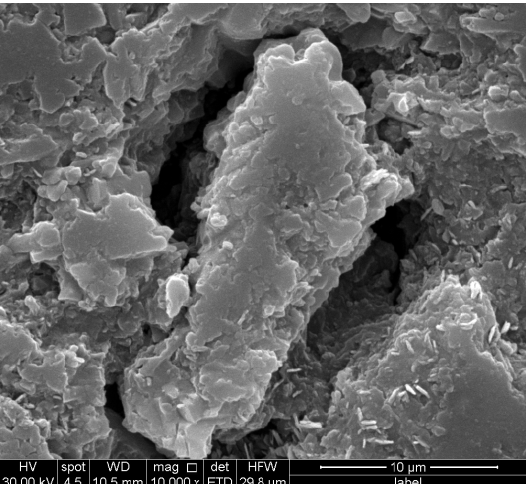
Figure 9. Enlarged image of the surface morphology of SN20 pins at the speed of 0.52 m/s. When the SN5 and SN10 pins slide against the PEEK disc in seawater, the variation in friction and wear behavior with speed is similar to that of the SN20/PEEK pair. Rough worn surfaces of the SN10 and SN5 pins at a speed of 0.52 m/s can be observed, as shown in Figures 10a and 11a, while the relatively smooth surfaces at a speed of 1.73 m/s can be clearly observed in Figures 10b and 11b. So, for these pairs, the increase in speed promoted the progress of tribochemical reactions and inhibited the degree of mechanical meshing. However, when the hBN content reached 30 wt.%, serious degradation of the mechanical properties led to a very rough wear surface during the friction process. In this case, the mechanical meshing was unavoidable, even when the friction pair was cooled and lubricated by seawater, so friction is the combination of mechanical meshing and molecular resistance. Thus, the friction coefficients of the SN30/PEEK pair were higher than those of SN20/PEEK. Moreover, an increase in speed aggravated the fracture and spalling of the ceramic pins and mechanical meshing, so the friction coefficient and wear rate of the SN30/PEEK pair increased with increasing speed.